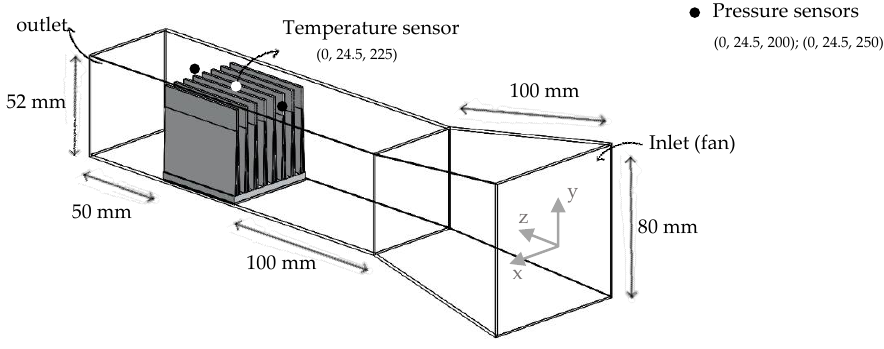
Figure 1. Computational domain.